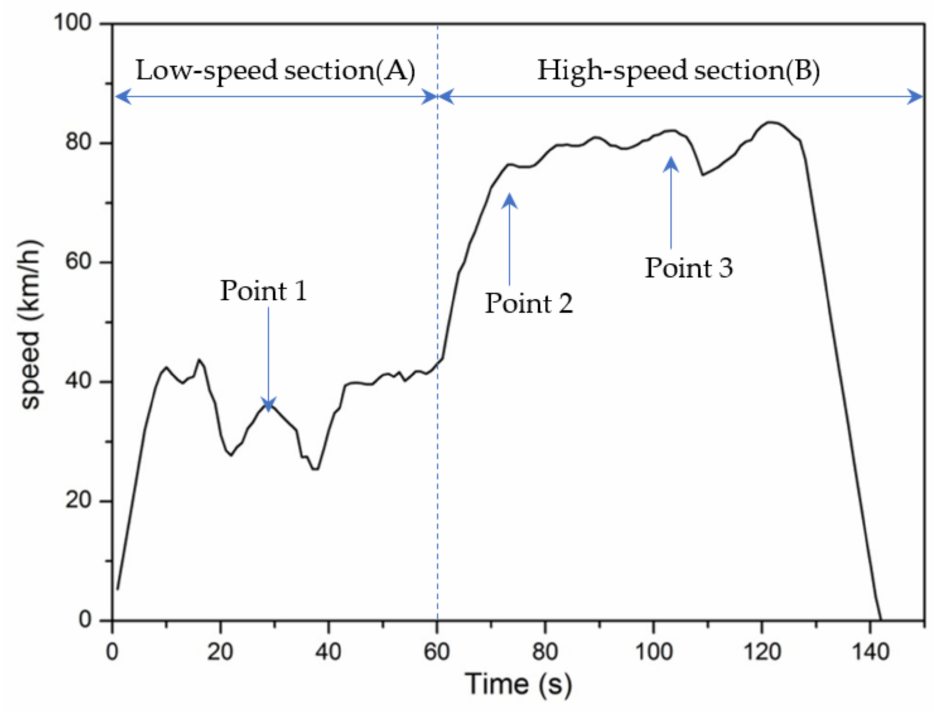
Figure 4. Profile of KD-147 driving mode.